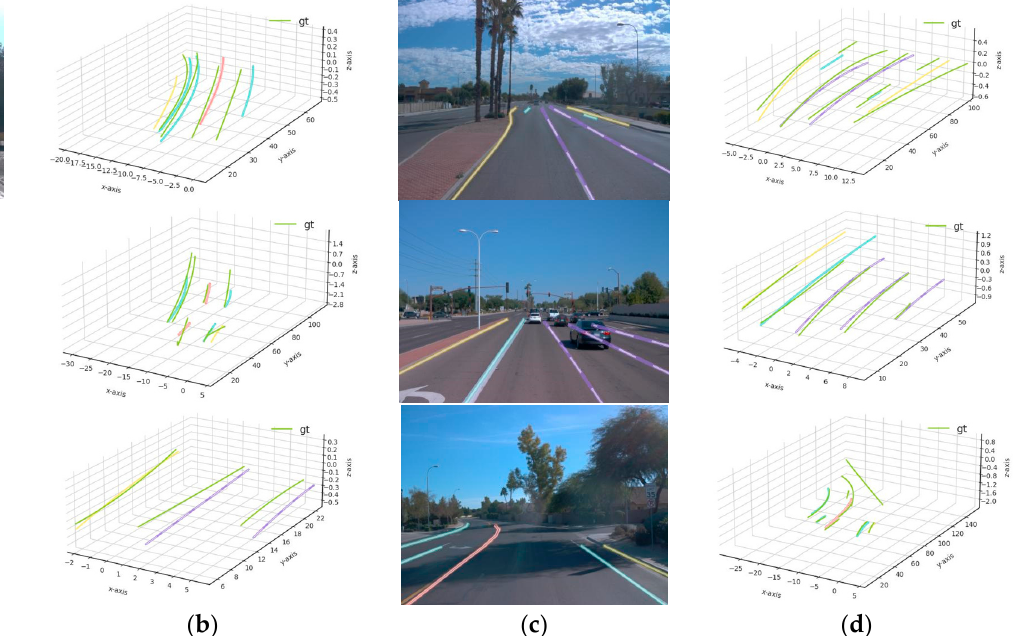
Figure 4. Results of 2D and 3D lanes obtained from the proposed method: ( a ) 2D results of intersection case; ( b ) 3D results of intersection case; ( c ) 2D results of the merge and split case; ( d ) 3D results of merge and split case.